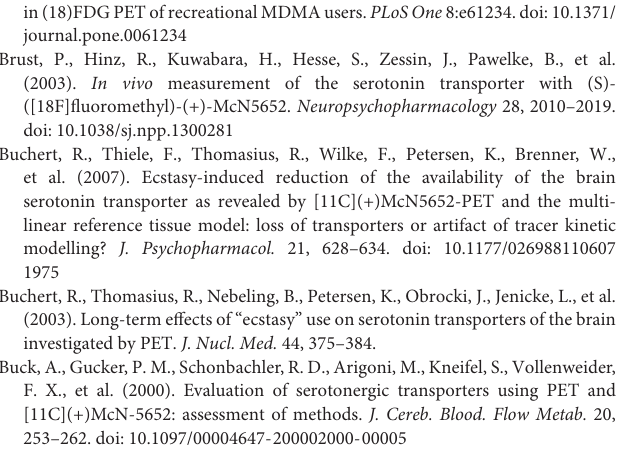
Supplementary Figure 1 | Structures of [ 123 I]I-ADAM and 4-[ 18 F]ADAM. Supplementary Table 1 | Regional specific uptake ratios (SUR) of 4-[ 18 F]ADAM in the brain. Data are presented as mean ± SEM; *p < 0.05, **p < 0.01 compared to the control group. Supplementary Table 2 | Recovery of serotonin transport (SERT) availability during the study period. Data are presented as mean ± SEM; * p < 0.05, ** p < 0.01, *** p < 0.005 compared to the control group; # p < 0.05 compared to the MDMA